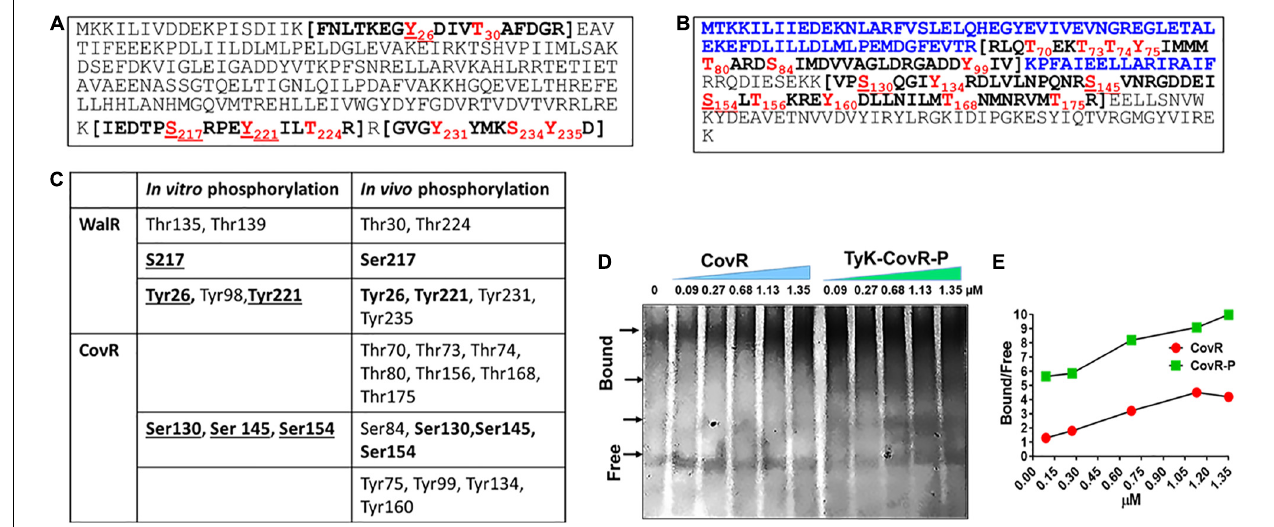
FIGURE 6 | In vivo phosphorylation of WalR and CovR. (A,B) Mass-spectrometry analysis of the in vivo phosphorylated WalR (A) and CovR (B) . In vivo phosphorylation of His-WalR and His-CovR was achieved by purifying Ni-NTA affinity column-purified His-WalR and His-CovR from the whole-cell extract of the M1T1 (cid:49) SP-PTP:: His-walR or M1T1 (cid:49) SP-PTP:: His-covR strain constructed by complementing M1T1 (cid:49) PTP mutant with the His-walR or His-covR gene using pDC123 plasmid. Phosphorylated residues are shown in red fonts The N-terminal sequence of CovR shown in blue fonts (the N-terminal half) is a regulator-CovRR, and the sequence in the bracket are the trypsin fragments detected by Mass-spectromtery. (see also Supplementary Table 6 for the detailed mass spectrometry analysis). (C). Comparison with in vitro and in vivo phosphorylated residues of WalR and CovR. Residues in bold fonts depict their presence both in vivo and in vitro under the provided conditions. (D) Electrophoretic Mobility Shift Assay (EMSA), showing the binding of purified non-phosphorylated and phosphorylated CovR with the promoter covR (P covR ) at different concentrations as indicated. Free and differentially migrated bound forms of the P covR DNA probe (266 bp) bands were resolved on 6% native gel and visualized using SYBRGreen stain as described in the “Materials and Methods” section (see Supplementary Figure 4 ). Arrows indicate the positions of differentially migrated bands of the bound DNA probe with and without CovR and SP-TyK-phosphorylated CovR-P. The image is the PhotoShop software-converted revert image of the original image of the SYBRgreen-stained native gel (see Supplementary Figure 5 ). (E) Bound and free bands were quantitatively analyzed by spot densitometric analysis using the ImageJ software. Each data point in the line graph shows a ratio of Bound vs. Free arbitrary densitometric units of P covR preincubated with or without different concentrations (0.09–1.35 µ M) of non-phosphorylated CovR and SP-TyK-phosphorylated